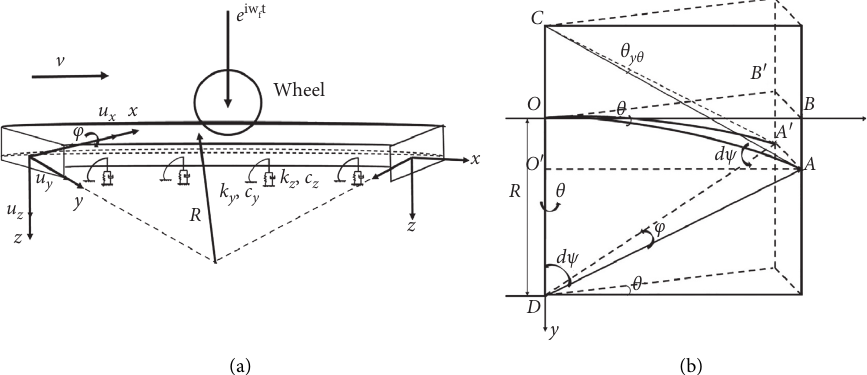
Figure 1: The geometric model for vibration analysis of curved beams: (a) mechanical model of curved beam; (b) geometric coupling of bending and torsion deformation.